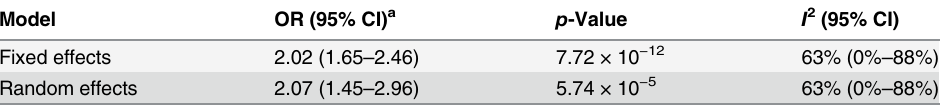
Table 2. Mendelian randomization estimate of the association of decreased 25OHD with the risk of multiple sclerosis. Model